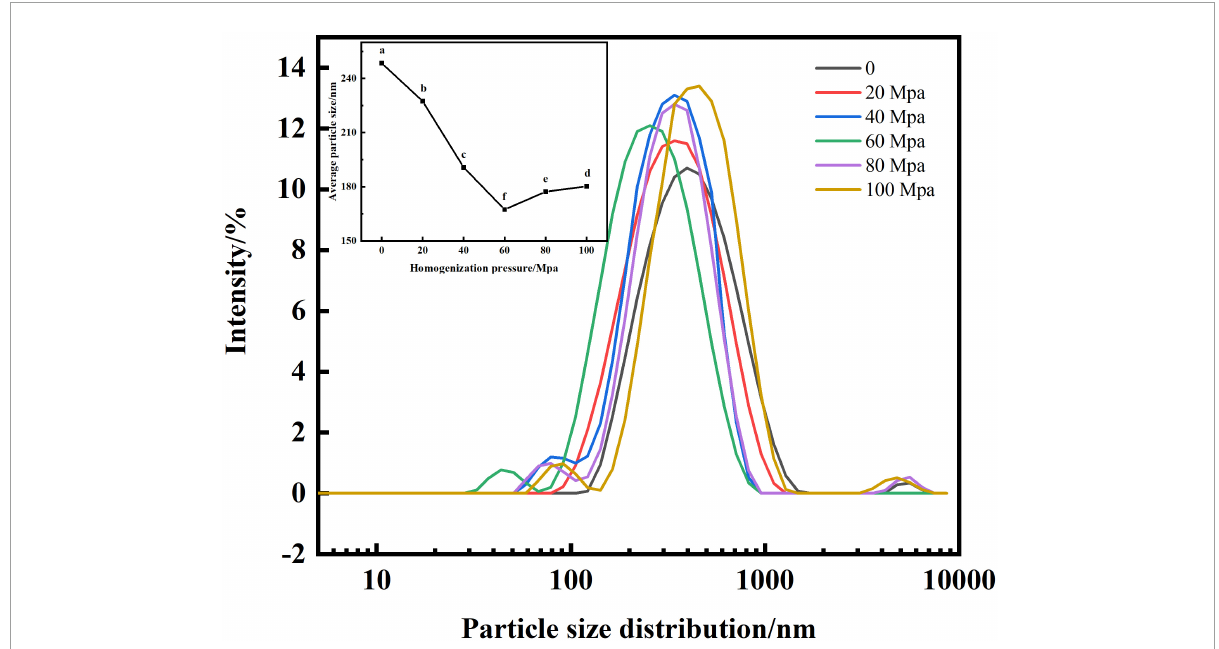
FIGURE2 Effect of high-pressure homogenization (HPH) on particle size of enzymatic hydrolyzed soybean protein concentrate (SPC). Note: Different letters in the figures indicate significant differences ( P < 0.05), the same